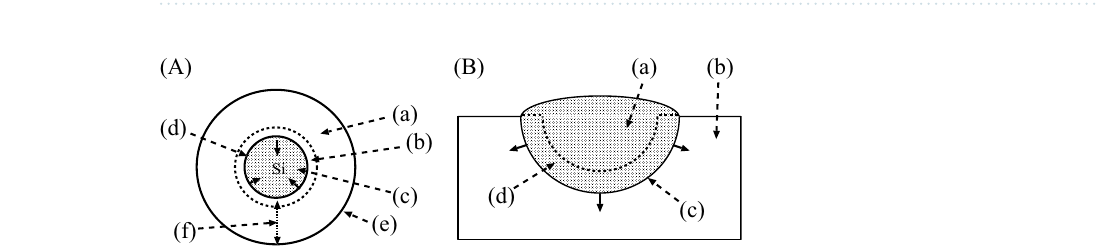
Figure 4. ( A ) The experimental data on the corrosion of aluminum alloys by the immersion with water of Red 21 1 ◦ C by using the specimens of (a) Al 7075, (b) Al 2024, and (c) Al 6061 after Al-Moubaraki and Sea at T = ± 0.5 and K 1.0 10 7 (g/m 3 ) at Al-Rushud 24 . (d)–(f) Results of the calculations by using Eqs. (1)–(3) with A = = × 21 ◦ C by using (d) E eff 0.738 (eV), (e) E eff 0.754 (eV), and (f) E eff 0.780 (eV). ( B ) Forecast of the T D = D = D = = 21 1 ◦ C corrosion of aluminum alloys by the immersion with seawater. (g)–(i): The experimental data at T = ± for (g) Al 7075, (h) Al 2024, and (i) Al 6061 after Al-Moubaraki and Al-Rushud 24 . (j)–(l): long-term forecast of 10 (y) at T 21 ◦ C. A , t the corrosion of aluminum alloys by using Eqs. (1) and (4) plotted in the range 0 ≤ ≤ = eff K , and E D are the same as those of (d)–(f).